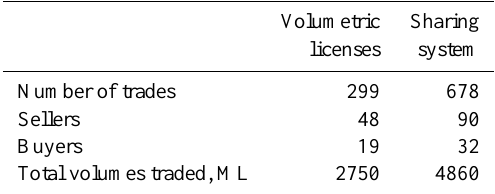
Figure 3. River flow at the last gauge in the basin (marked A in Fig. 1).